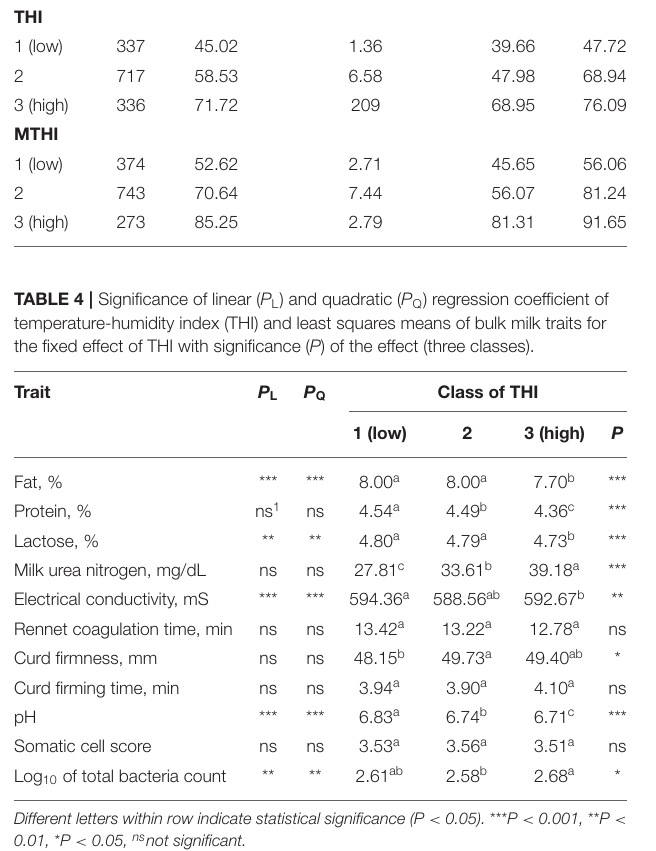
TABLE 3 | Descriptive statistics of temperature-humidity index (THI) and maximum of temperature-humidity index (MTHI) for each class. Class